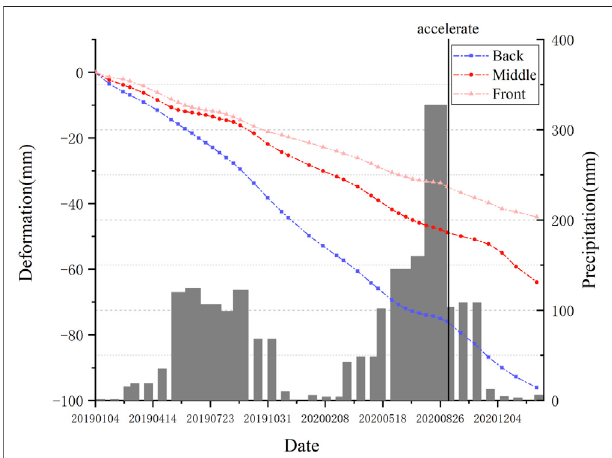
FIGURE 13 | Time-series deformation and precipitation of three